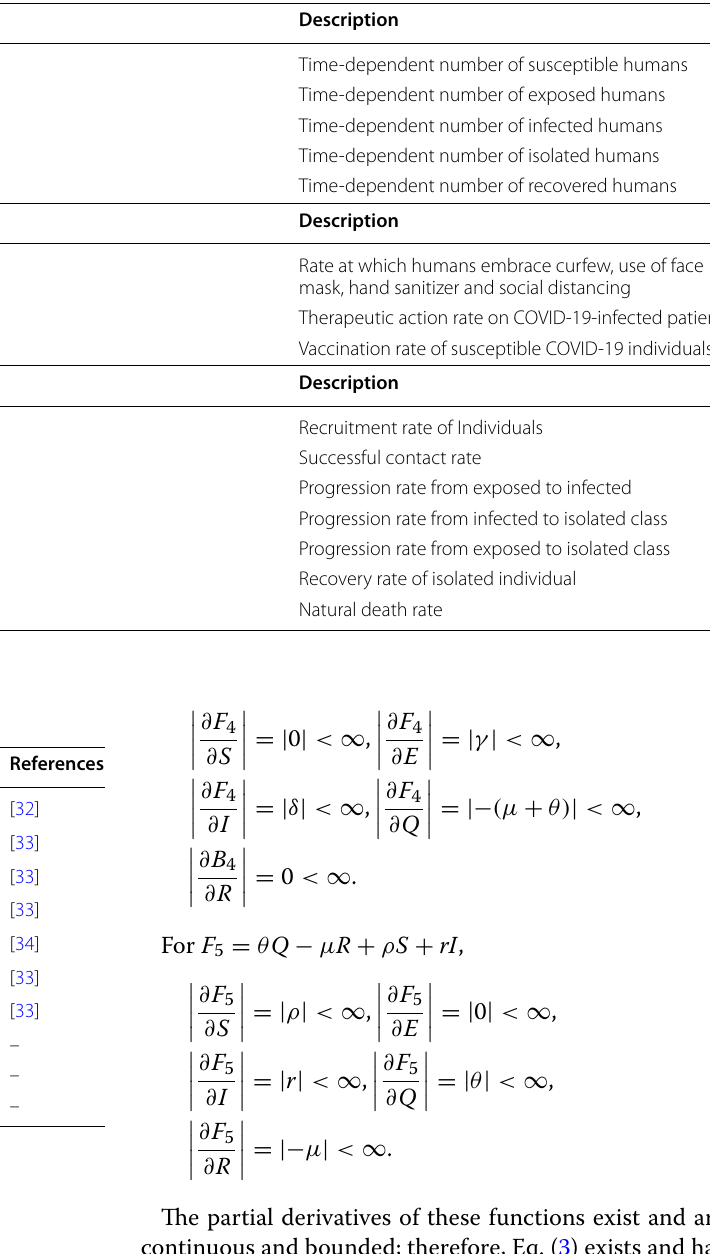
Table 1 Description of parameters